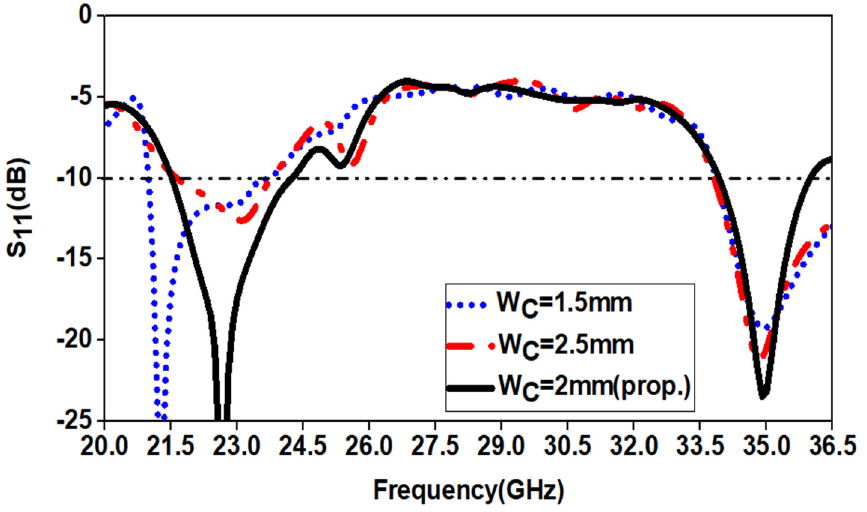
Figure 10. Analysis of variation in the width of second type ground cut W C .